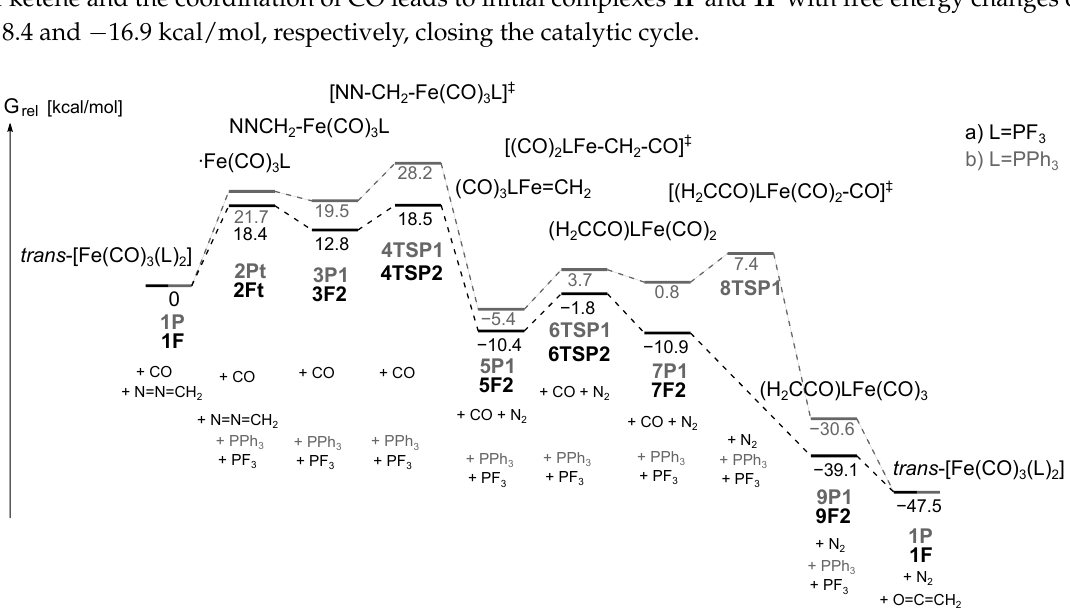
Figure 10. Free energy profile of the diazocarbonylation reaction catalyzed by iron–carbonyl–phosphine complexes. Free energy values are given in